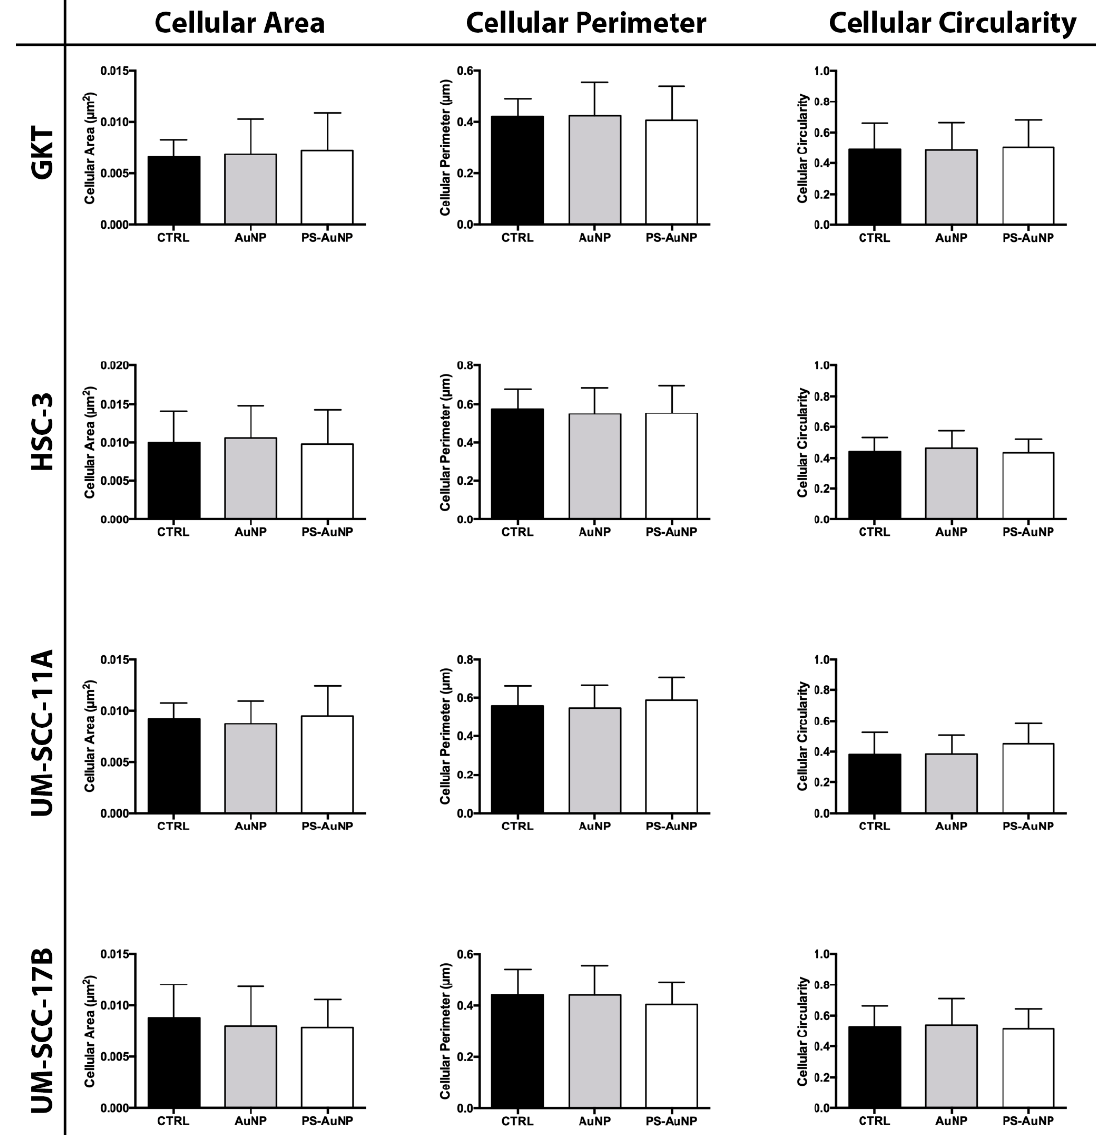
Figure 8. PS-AuNPs do not induce significant changes in cellular area, perimeter, and circularity in either a normal oral (GKT) cell line or in all oral cancer cell lines. Cellular Area (left), Cellular Perimeter (Center), and Cell Circularity (Right) of GKT normal prostate cell line and the prostate cancer cell lines HSC-3, UM-SCC-11A, and UM-SCC-17B.